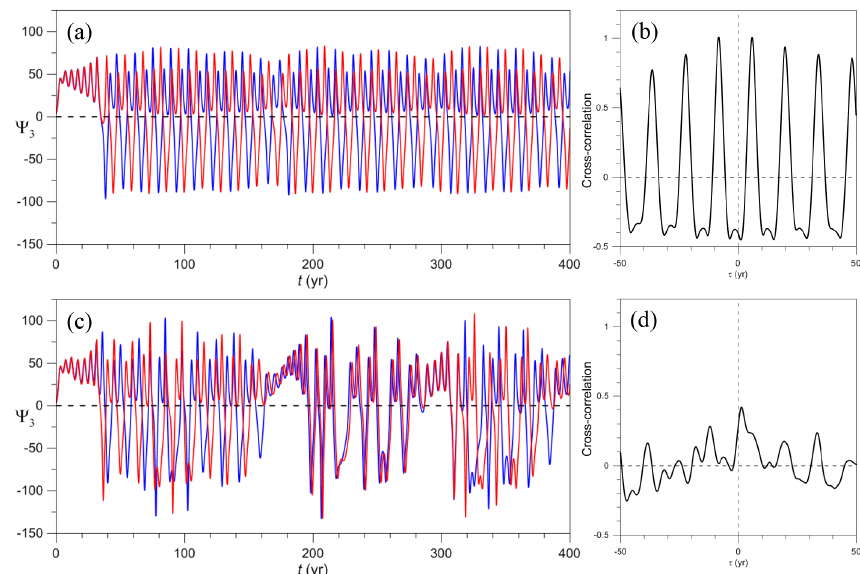
Figure 18. Role of the cross-correlation diagnostics in characterizing chaotic behavior for an aperiodically forced system, given by Eqs. (2) and (11); γ = 1 . 1. (a) Time evolution of (cid:57) 3 for ε (cid:48) = 0 . 05 in Eq. (11) and (b) corresponding cross-correlation. (c, d) Same as panels (a) and (b) but for ε (cid:48) = 0 . 2. The trajectories initialized at P 2 are in red and those initialized at a nearby point are in